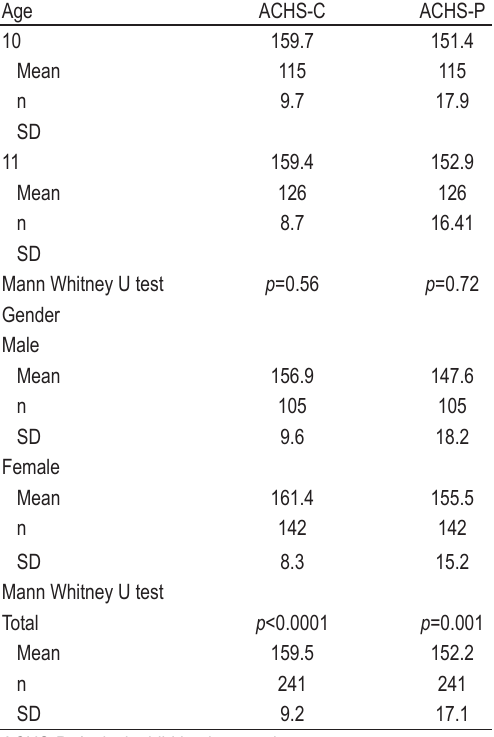
TABLE 2. Mean ACHS scores by age and gender